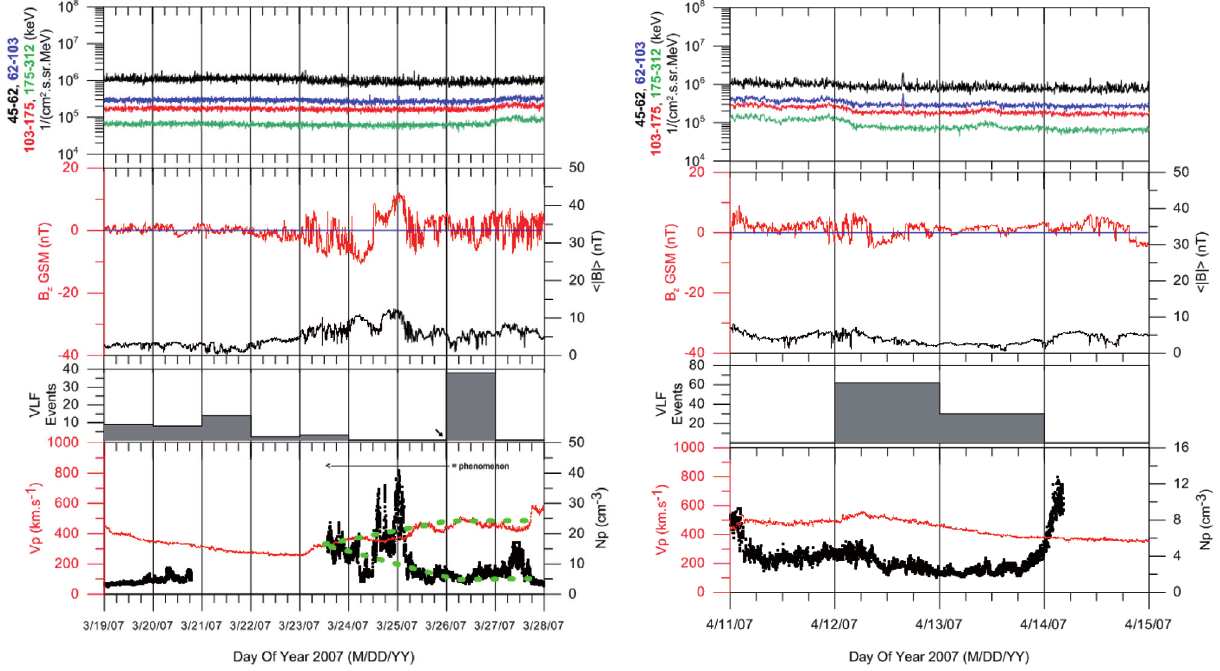
Figure 7. As for Figure 5, for Case C: Mar 19-26. Figure 8. As for Figure 5, for Case D: Apr 12-13.